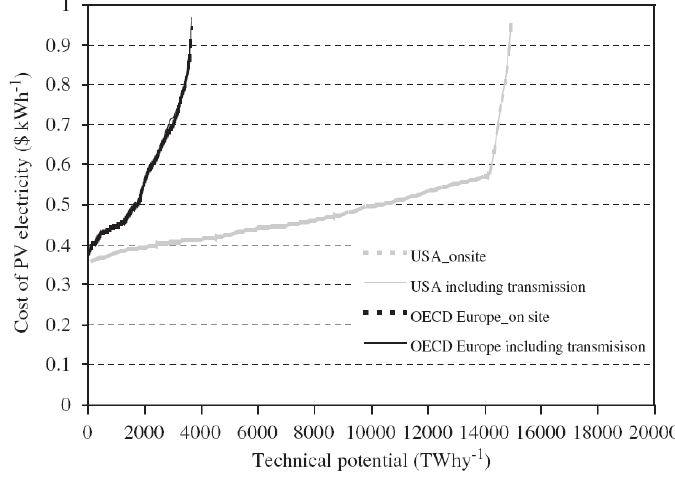
Figure 56. Technical potential of PV as a function of generation cost [191]. The realisable economic potential is critically dependent on how much generation cost can be lowered to achieve cost parity (including externalities). © 2007 Elsevier, reproduced with